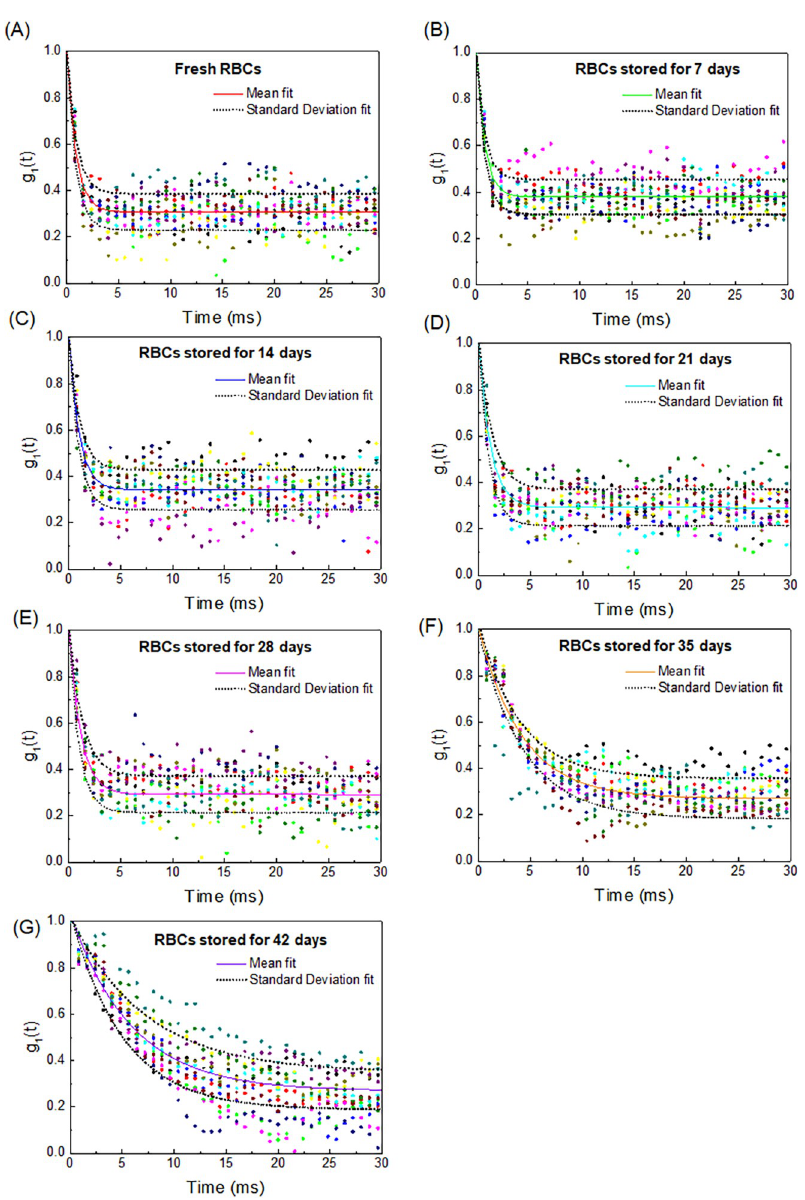
Fig 2. Speckle correlation curves for fresh RBCs and stored RBCs on days 7, 14, 21, 28, 35, and 42 of storage. The center of the bold line with different colors shows the double exponential curve fitting from the sample mean value while the two outer dotted lines indicate the curve fitting from the sample standard deviation. Data points are shown for 13 datasets of fresh RBCs and stored RBCs for 7, 14, 21, 28, 35, and 42 days (A ~ G). The mean decorrelation curve is overlaid as a continuous line ( n =